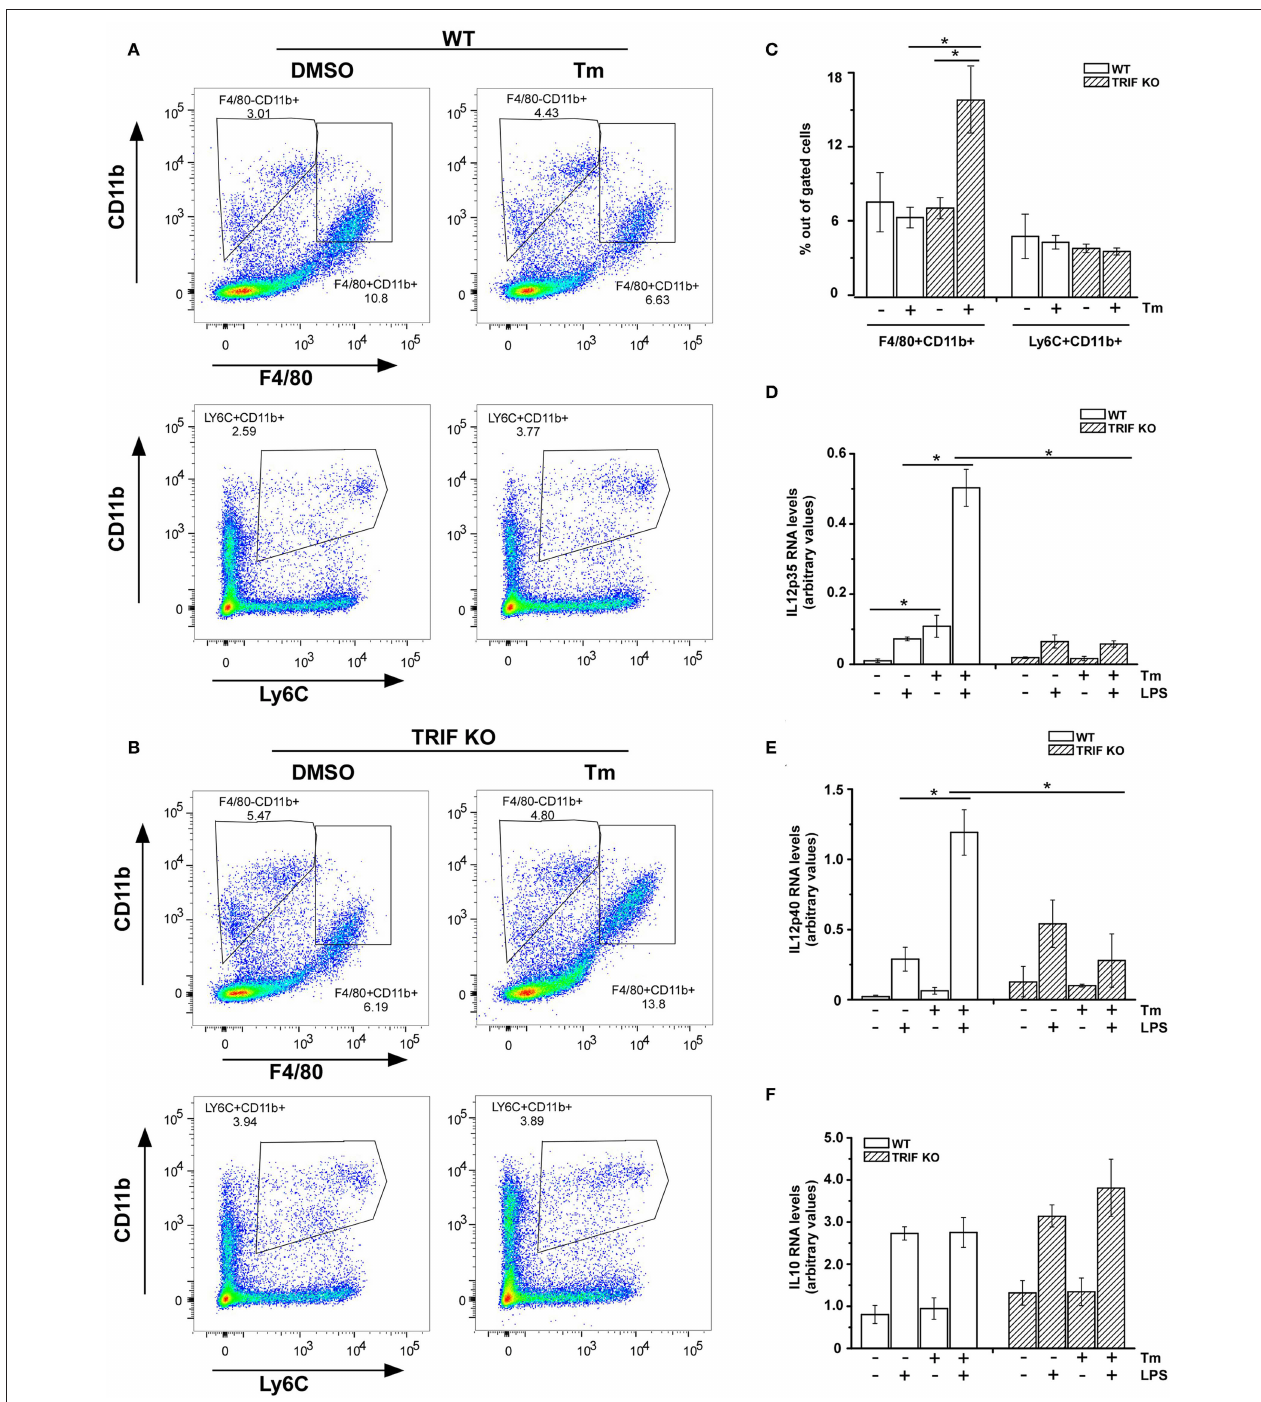
FIGURE 4 | Resident macrophages from liver are sensitive to stress-induced change in cytokine mRNA expression. (A,B) WT (A) and TRIF-/- (B) mice were challenged with DMSO or Tm (1.25 mg/kg body weight) for 18h prior to the isolation of non-parenchymal cells from the liver. The non-parenchymal cells were immunostained for surface CD11b, Ly6C, and F4/80 and subjected to flow cytometry analysis. (C) The percentage of LY6C + and F4/80 + cells within the gated populations isolated from livers of mice treated with DMSO vs. Tm ( n = 4). (D–F) Liver non-parenchymal cells from WT or TRIF-/- mice treated with DMSO or Tm were labeled with anti-CD11b-PE antibody and then isolated using anti-PE magnetic microbeads. CD11b + cells were subsequently treated with or without LPS (100ng/ml) for 3h. Total RNA was used to determine IL12p35 (D) , IL12p40 (E) , and IL10 (F) mRNAs by real time PCR. Data are presented as the mean ± SD of triplicate experiments for WT ( n = 3 per treatment for each experiments) and duplicate experiments for TRIF-/- mice ( n = 3 per treatment for each experiments). The differences between indicated treated samples were evaluated by two way-ANOVA and Turkey’s multiple comparisons test. * p < 0.05.